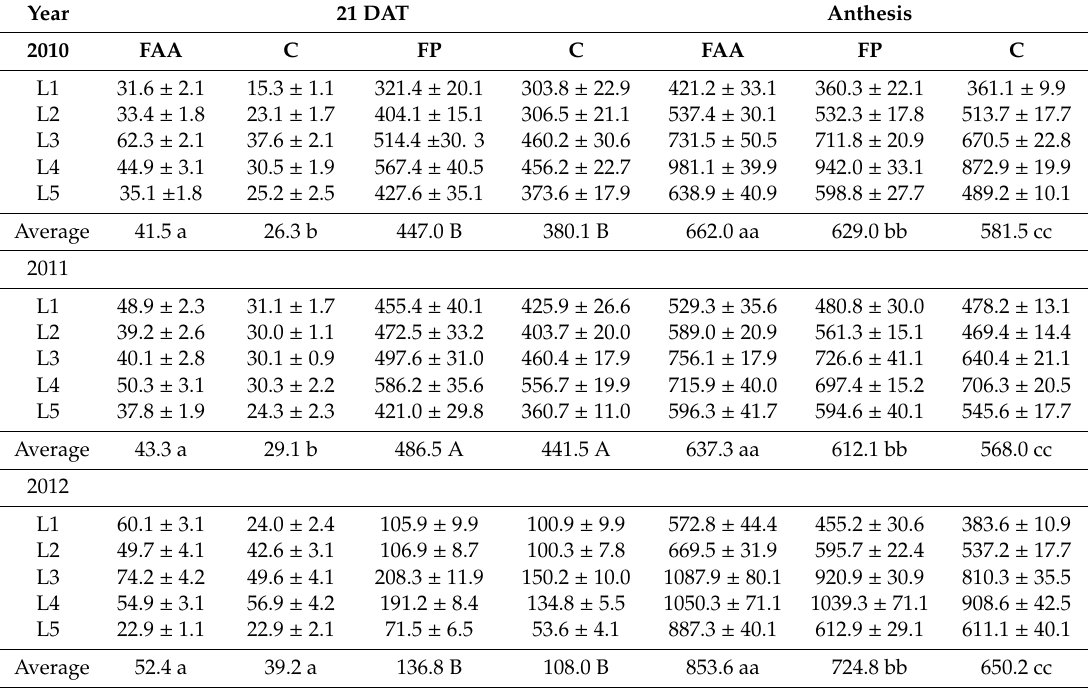
Table 6. E ff ects of applied fertilizers on maize fresh matter (g plant − 1 ) and standard error ( ± SE). Year 21 DAT